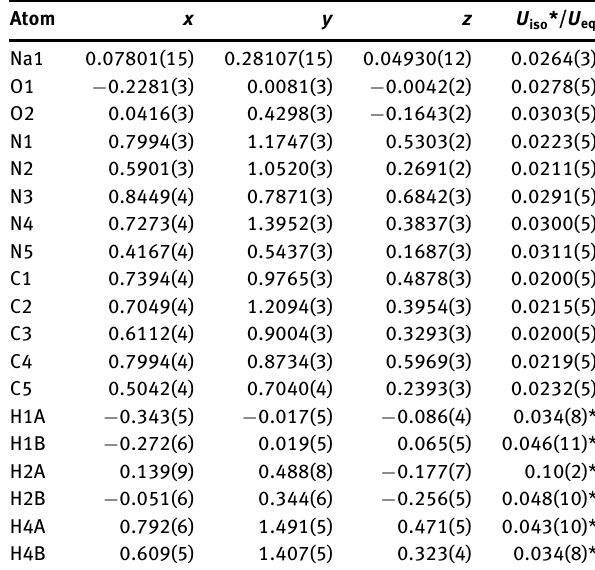
Table 1 contains crystallographic data and Table 2 contains the list of the atoms including atomic coordinates and dis- placement parameters.